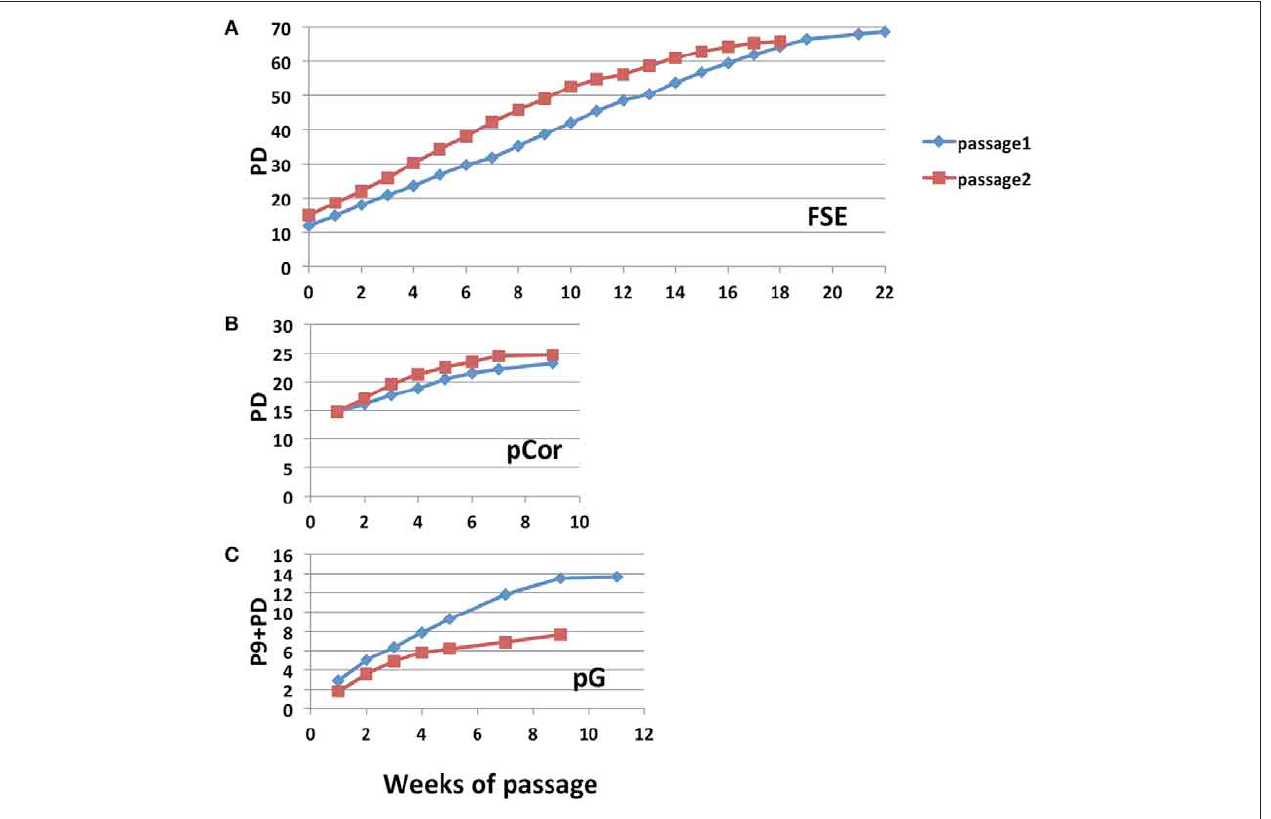
FIGURE 2 | ICF primary fibroblasts enter senescence at a low population doubling. Growth curves of control FSE (A) pCor (B) and pG (C) fibroblasts passaged twice in culture until